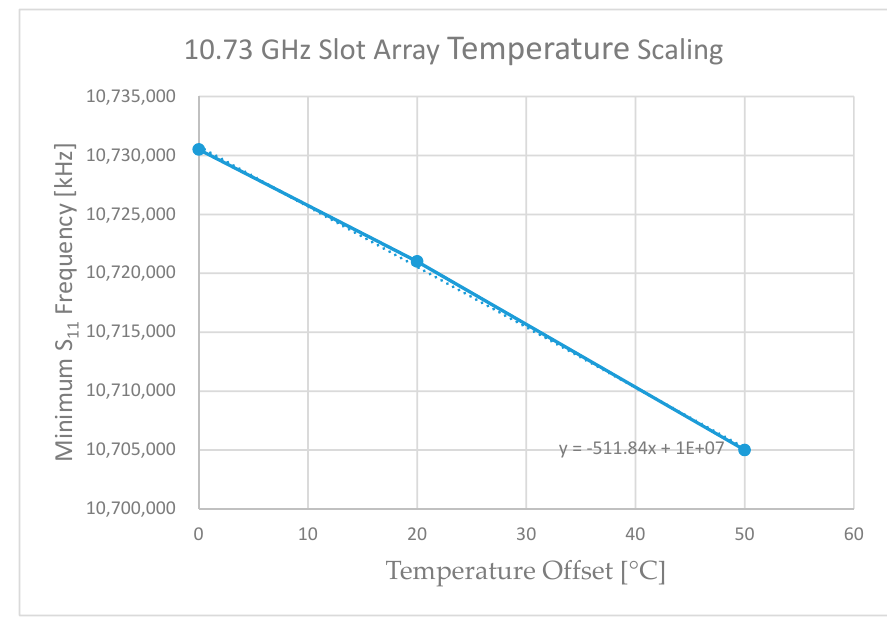
Figure 3. 10.73 GHz slot array temperature scaling.